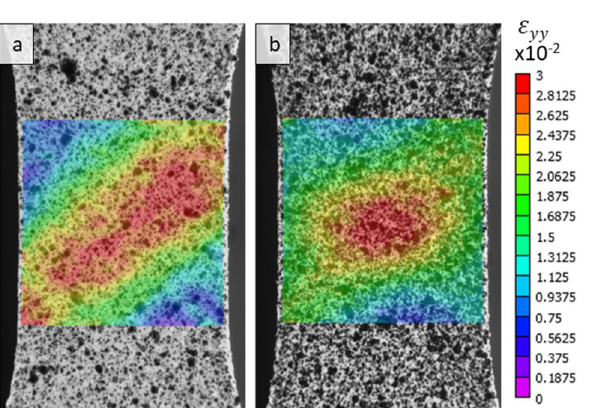
Figure 4. DIC strain fields ε yy under tension to ~ 0.01 true strain illustrating the differences in deformation between ( a ) as-extruded Mg–1.5Nd alloy and ( b ) annealed Mg–1.5Nd alloy at 375 °C for 15